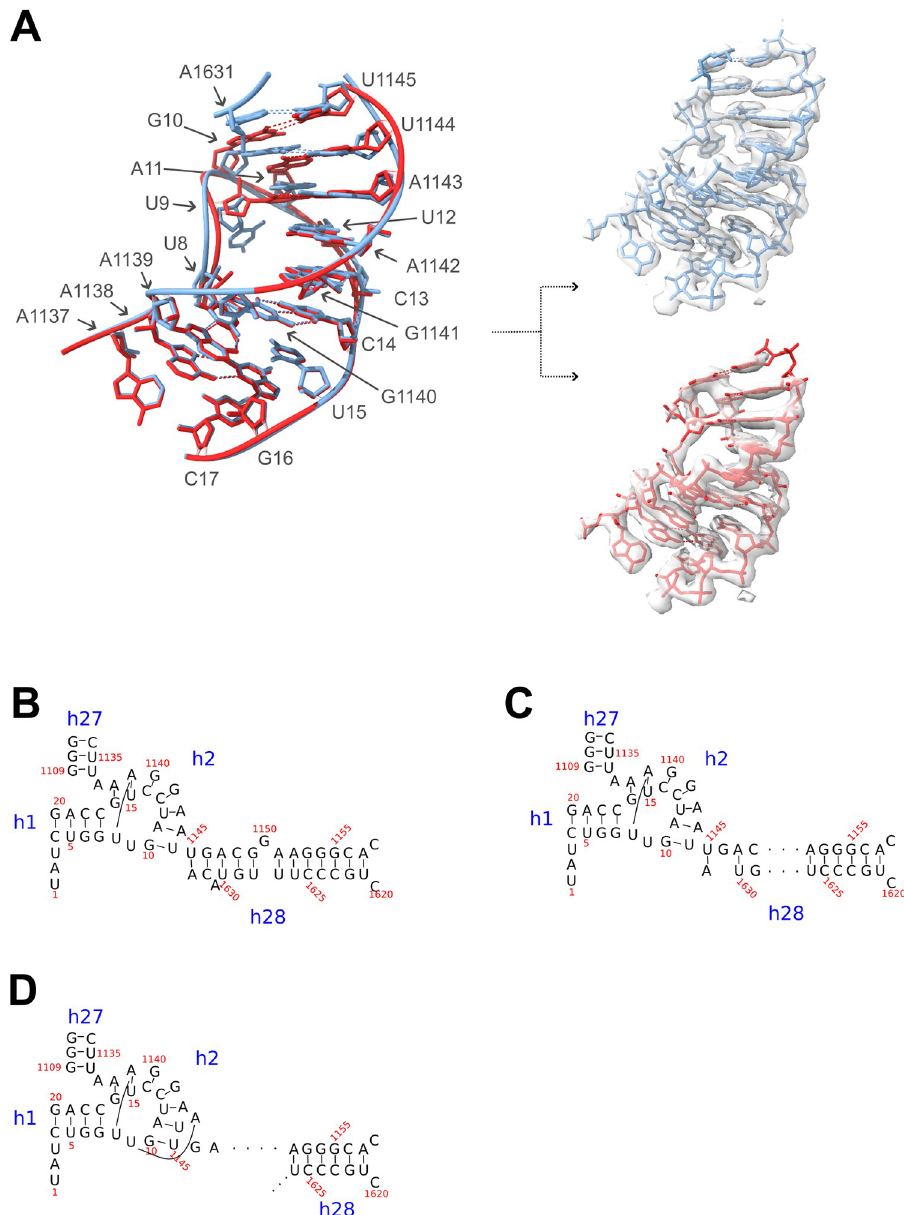
Fig 4. Structure model of the CPK-im in Enp1TAP-S21_A compared to the mature CPK in Enp1TAP_A particles. In (A) on the left, the structure models of CPK-im (red, Enp1TAP-S21_A particles) and the mature CPK (light blue, Enp1TAP_A particles) are superimposed. On the right, they are shown individually with the respective overlaid cryo- EM derived maps Enp1TAP-S21_A and Enp1TAP_A. In (B)—(D) secondary structure models are shown of the CPK in yeast mature ribosomes (B), in Enp1TAP_A particles (C), and in Enp1TAP-S21_A particles (D).